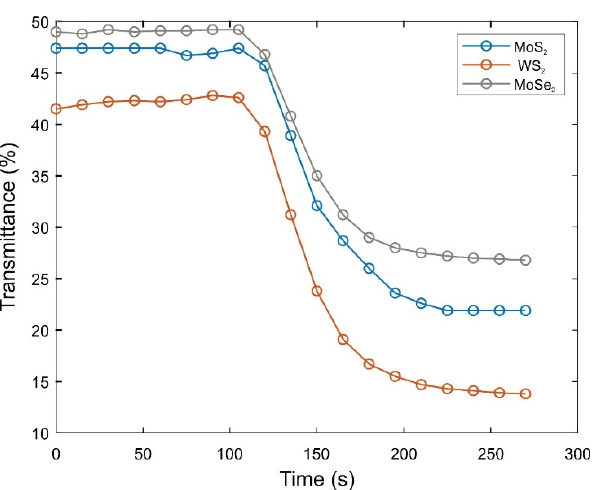
Figure 2. Transmittance versus gelation time graph of 2D materials-doped PAAm